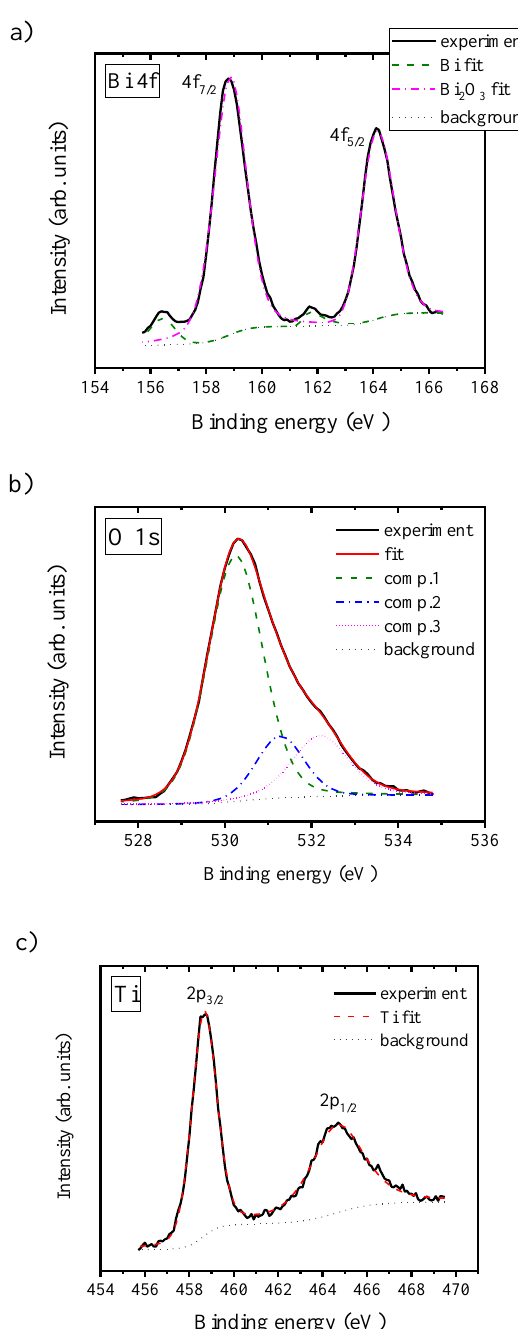
Figure 6. XPS profiles and respective fits for ( a ) Bi 4f, ( b ) O 1s and ( c ) Ti 2p core